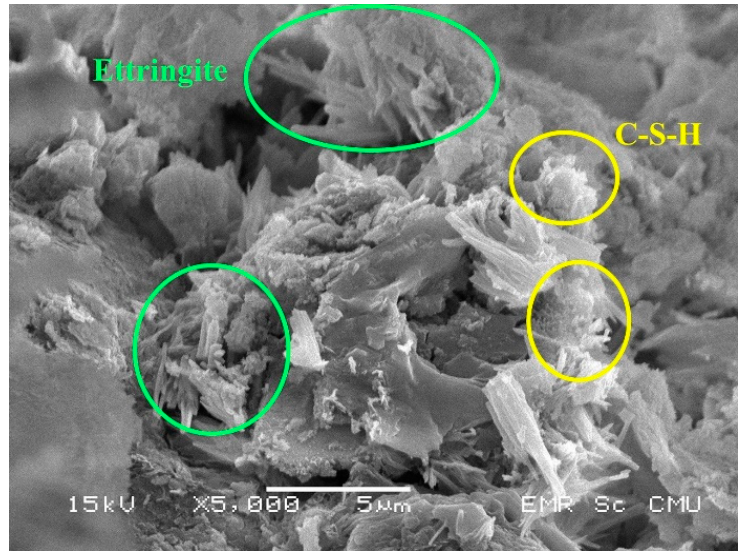
Figure 14. The SEM image of C1G1.